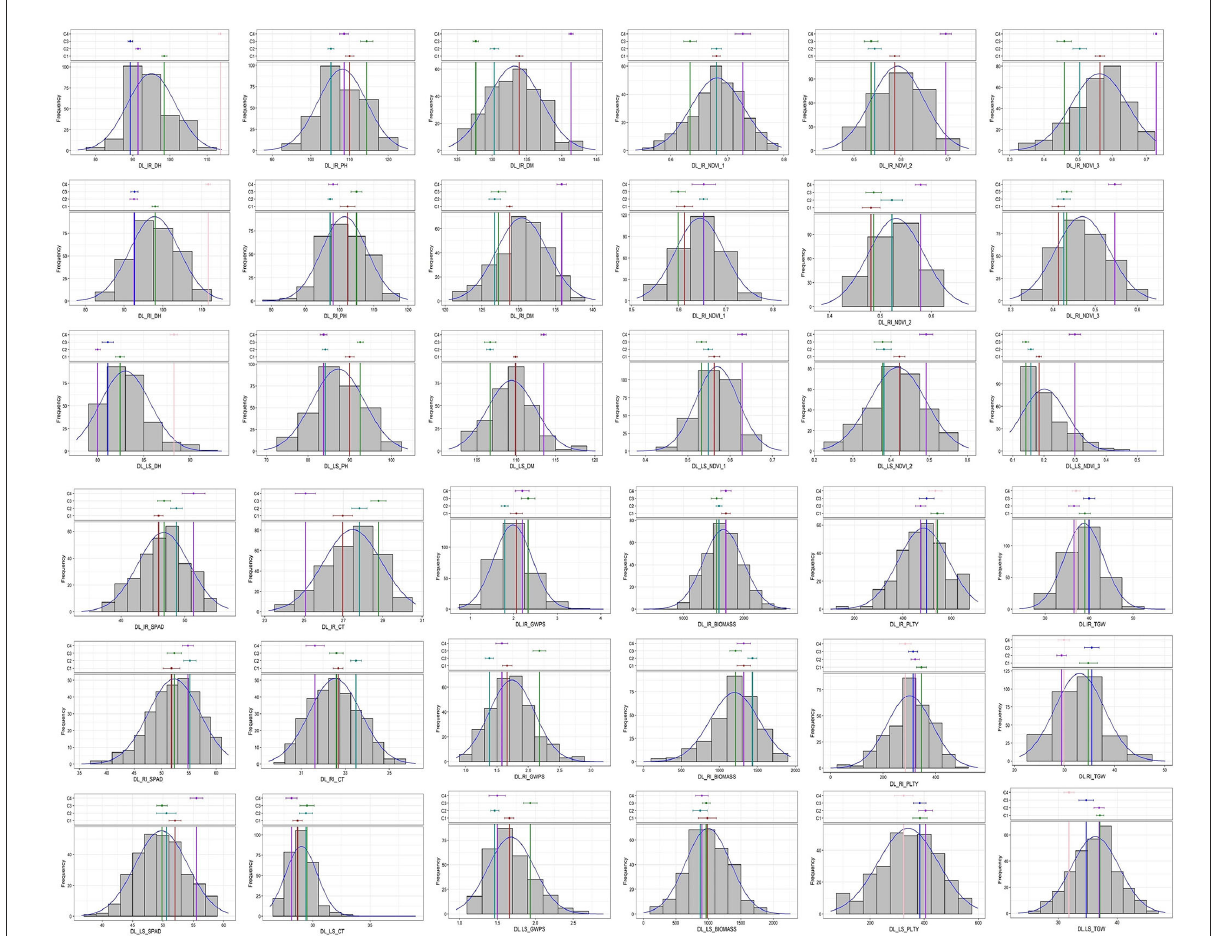
FIGURE1 Frequency distribution of studied traits in GWAS panel evaluated at IARI Delhi under three conditions viz ., IR, RI and LS during 2020–2021.